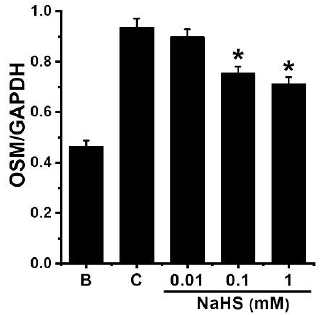
Figure 2. Inhibition of OSM mRNA expression by NaHS in dHL-60 cells. Cells (1 × 10 6 /mL) were pretreated with NaHS (0.01 to 1 mM) for 1 h, followed by GM-CSF-stimulation (5 ng/mL) for 30 min. Blank (B) corresponds to PBS treated cells without GM-CSF stimulation, and control (C) corresponds to PBS treated cells stimulated by GM-CSF. Results are expressed as the mean ± SEM from the three separate experiments. * p < 0.05, as compared with the PBS treated cells stimulated by GM-CSF.